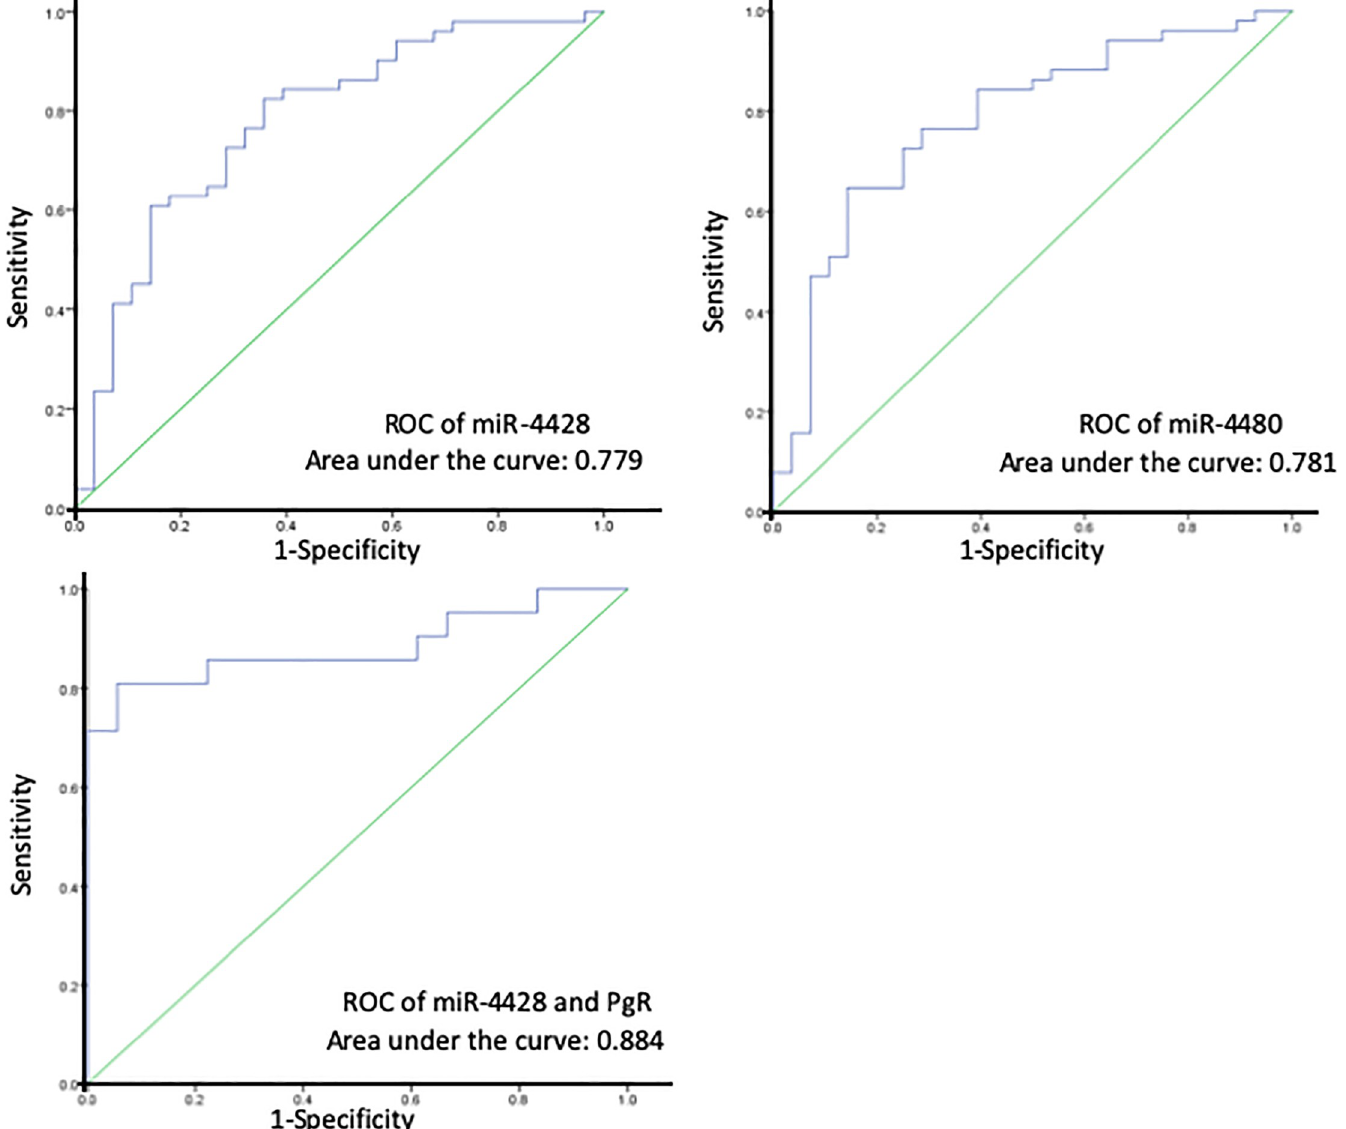
Fig 4. Receiver operating characteristic curve (ROC) analysis of the diagnostic index using miR-4428, miR-4480, and a combination of miR-4428 and progesterone receptor (PgR).